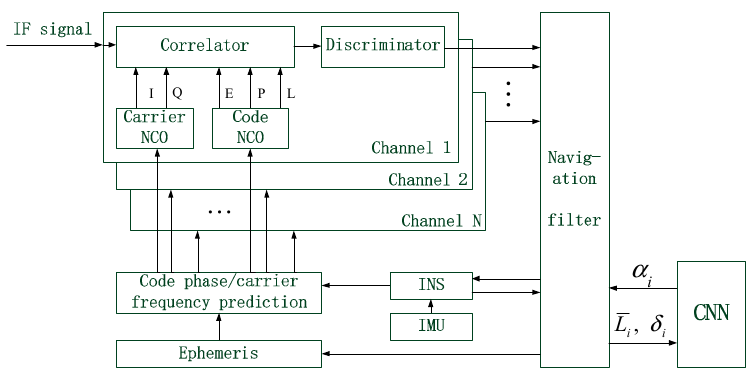
Figure 4. The structure of deep integration assisted by CNN.